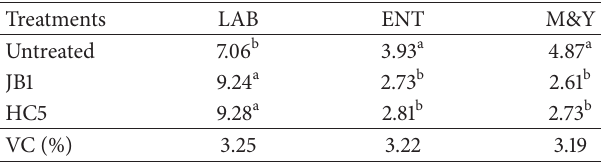
Table 1: Number of lactic acid bacteria (LAB), enterobacteria (ENT), and molds and yeasts (M&Y) in Tanzania grass before ensiling (log cfu g −1 ). Treatments LAB ENT M&Y Untreated 4.51 4.63 5.12 JB1 4.53 4.59 5.09 HC5 4.49 4.74 5.08